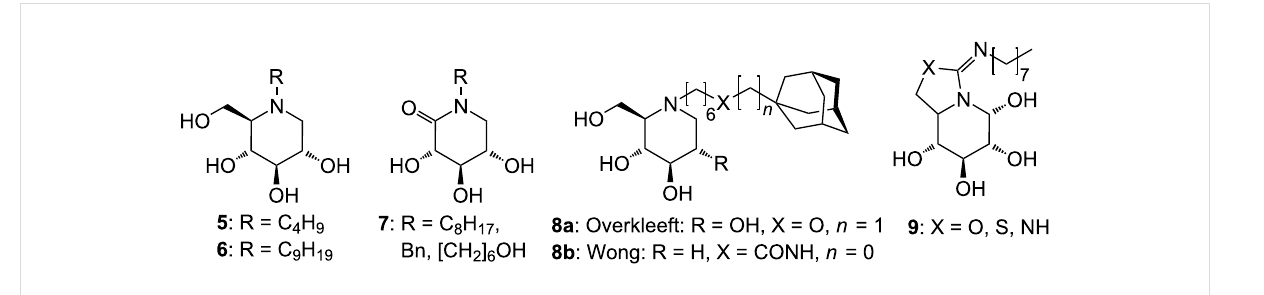
Figure 3: Structure of NOEV 10